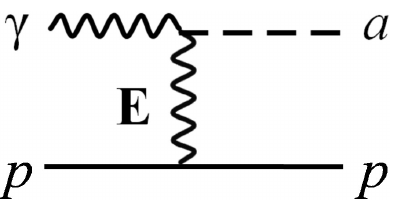
Figure 4. Feynman diagram for the Primakoff